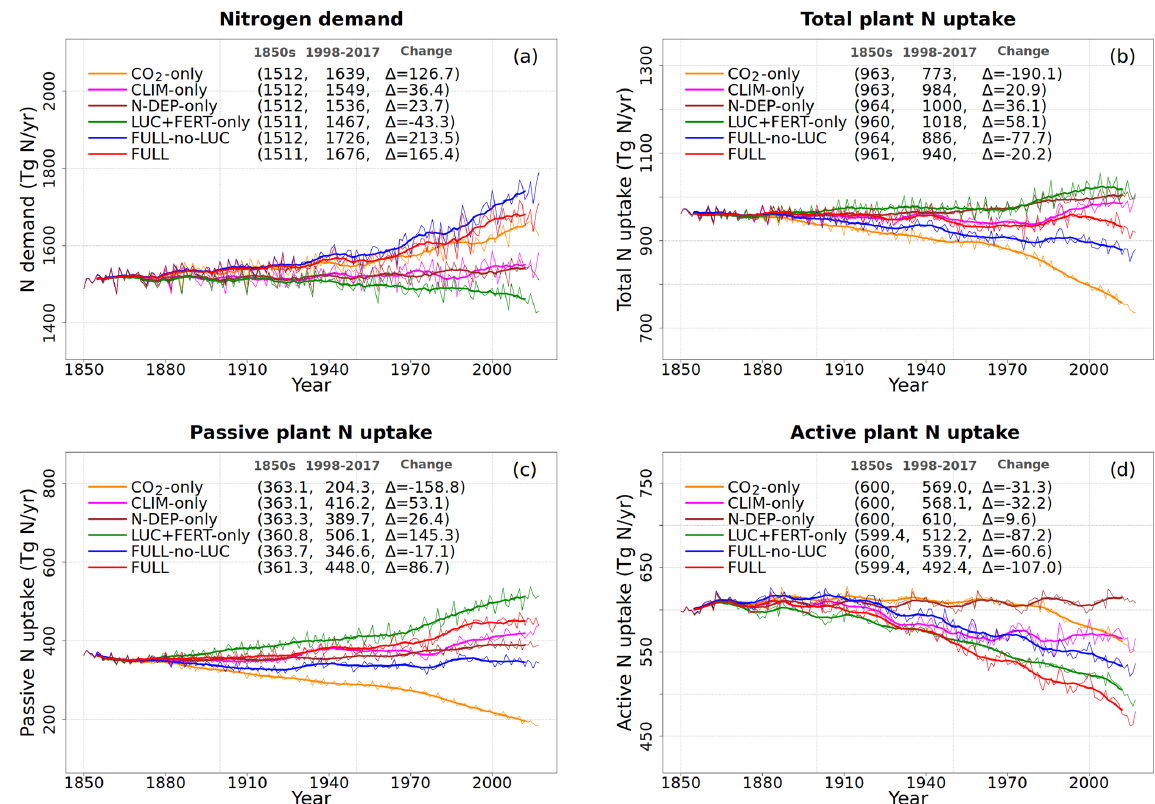
Figure 6. Global annual values of N demand (a) , total plant N uptake (b) , and its split into passive (c) and active (d) components for the primary simulations performed. The values in the parentheses for legend entries show the average for the 1850s, the average for the 1998–2017 period, and the change between them. The thin lines show the annual values, and the thick lines show their 10-year moving